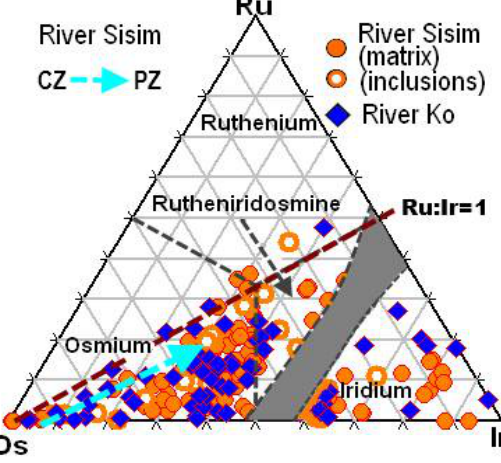
Figure 5. Compositional variations of grains of Os–Ir–(Ru) alloys from placer deposits associated with the River Sisim (this study) and River Ko [2] in terms of the Ru–Os–Ir diagram (atomic %). The blue arrow shows the variation, from the CZ toward the PZ, which exists in the zoned placer grain of Os–Ir–(Ru) alloy from Sisim (Figure 2h). The nomenclature and miscibility gap are in [6]. Placer grains of Pt–Fe alloy at Sisim are ≤ 0.5 mm in size, and they typically contain elevated levels of Cu (up to 1.9 wt %, Table 3). These grains exhibit variable Σ PGE/(Fe + Cu + Ni) ratios, typically close to 3, thus corresponding to isoferroplatinum (or ferroan